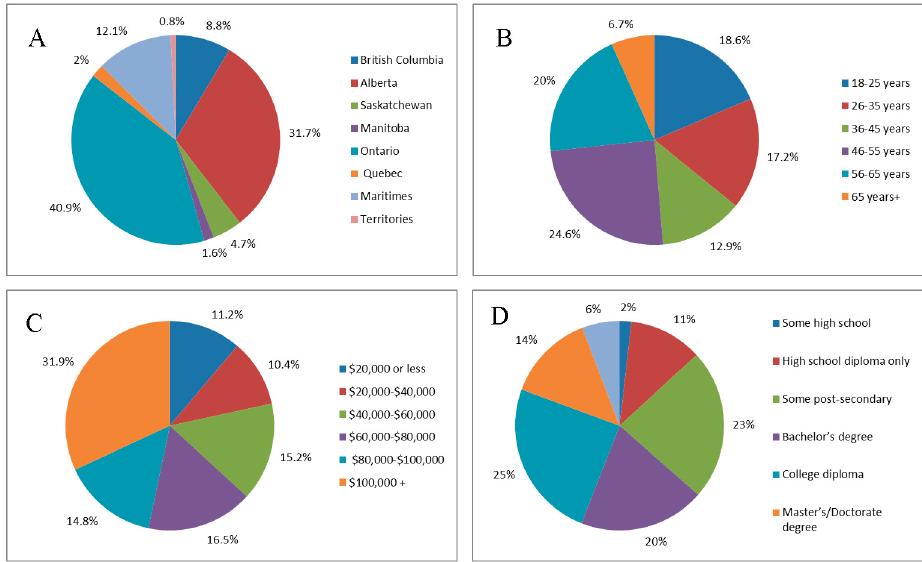
Figure 1. Pie graphs illustrating the spread of participants (n = 901) in the demographic categories